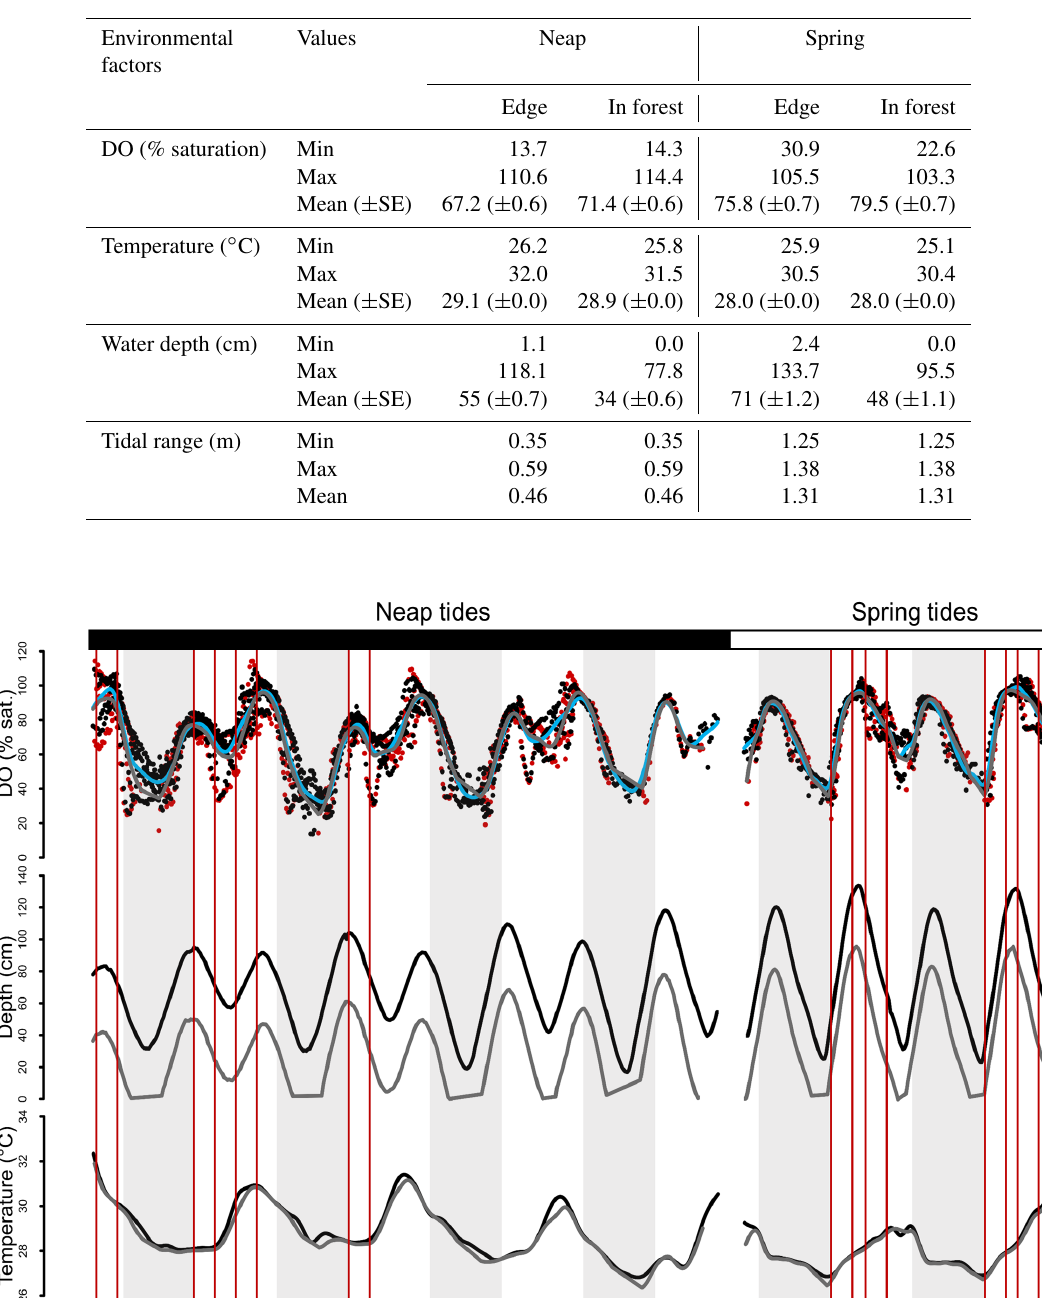
Table 1. Summary of the environmental factors during the study period. For each factor, the minimum, maximum and mean ( ± SE) values are provided for neap tides and spring tides on the edge and in-forest sites.